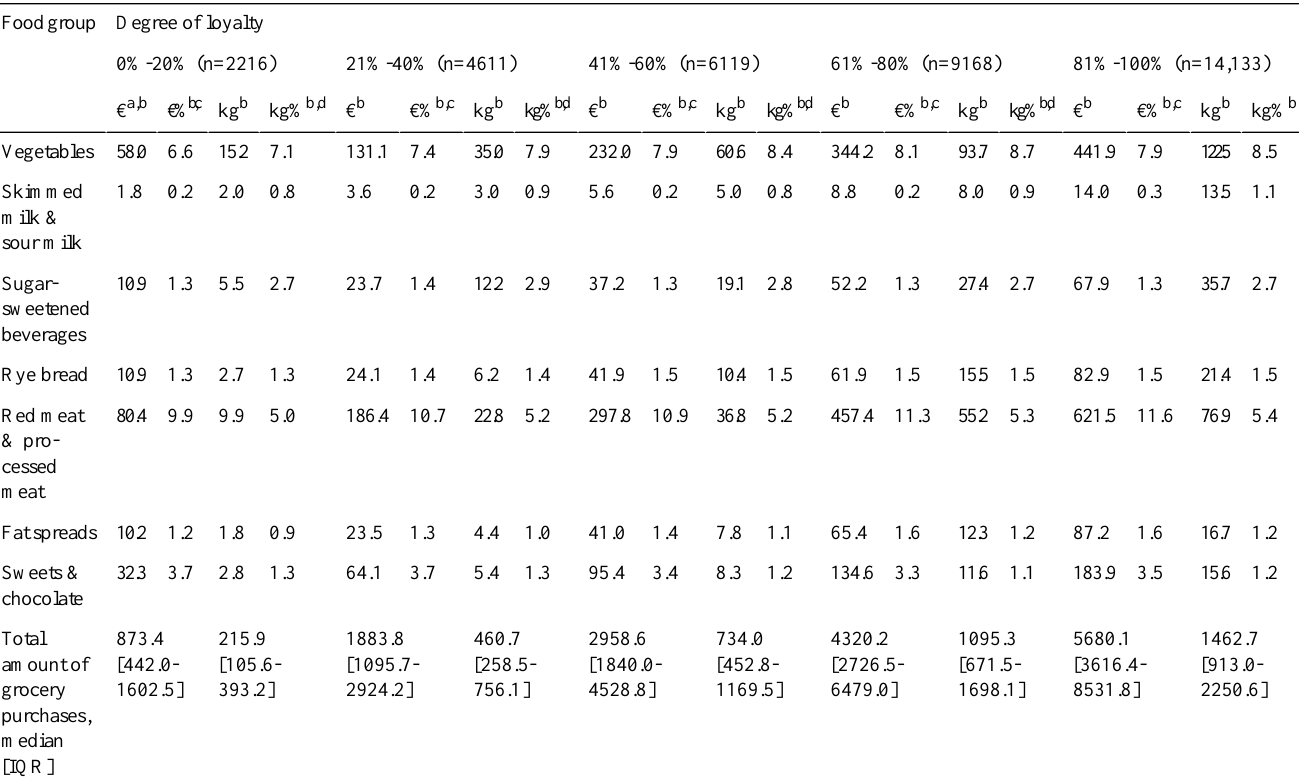
Table 4. Purchases (in € and kg) of selected food groups across the five degree of loyalty groups. Degree of loyaltyFood